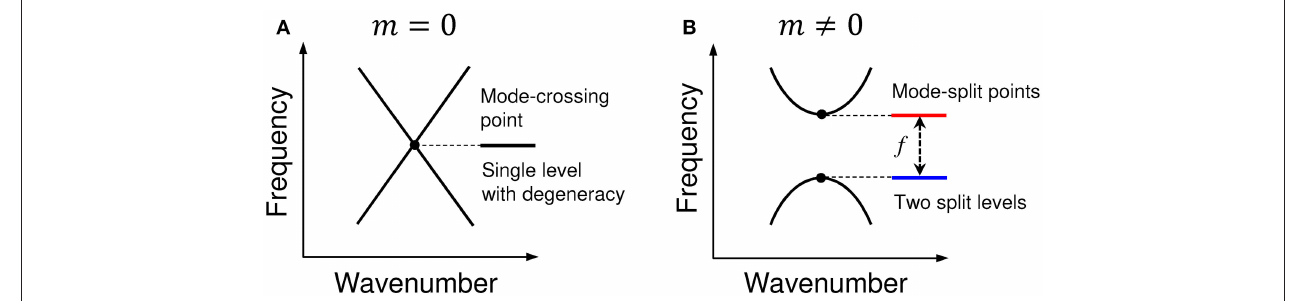
0, which can be regarded as a single level with degeneracy, and (B) mode-split points with =